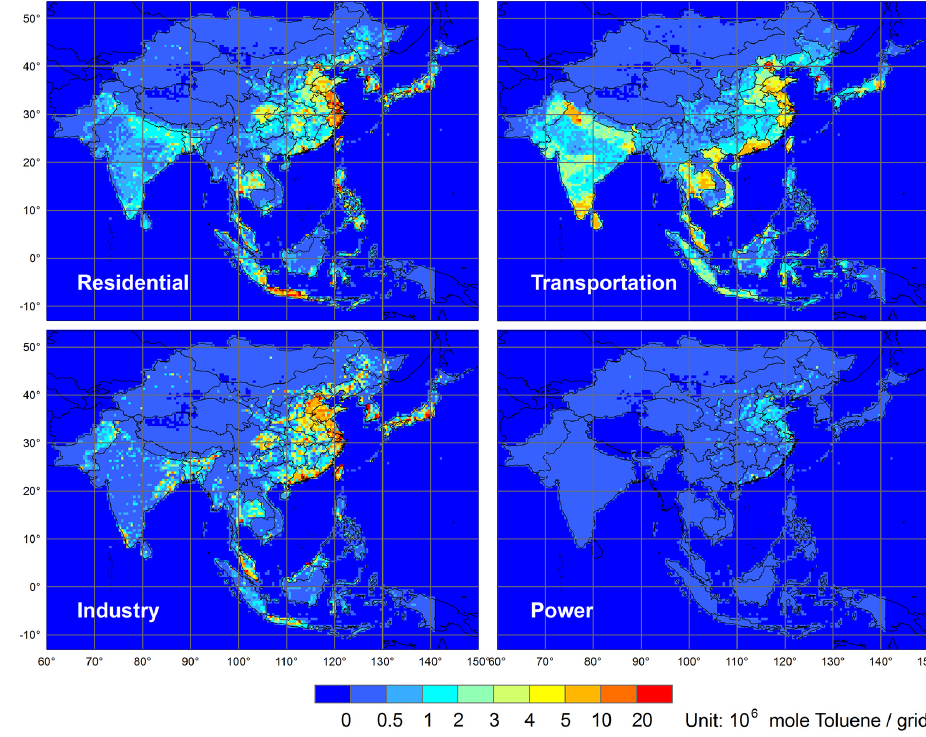
Figure 7. Emission distribution of toluene by sector at 30min × 30min resolution (unit: 10 6 moleyr − 1 per grid).